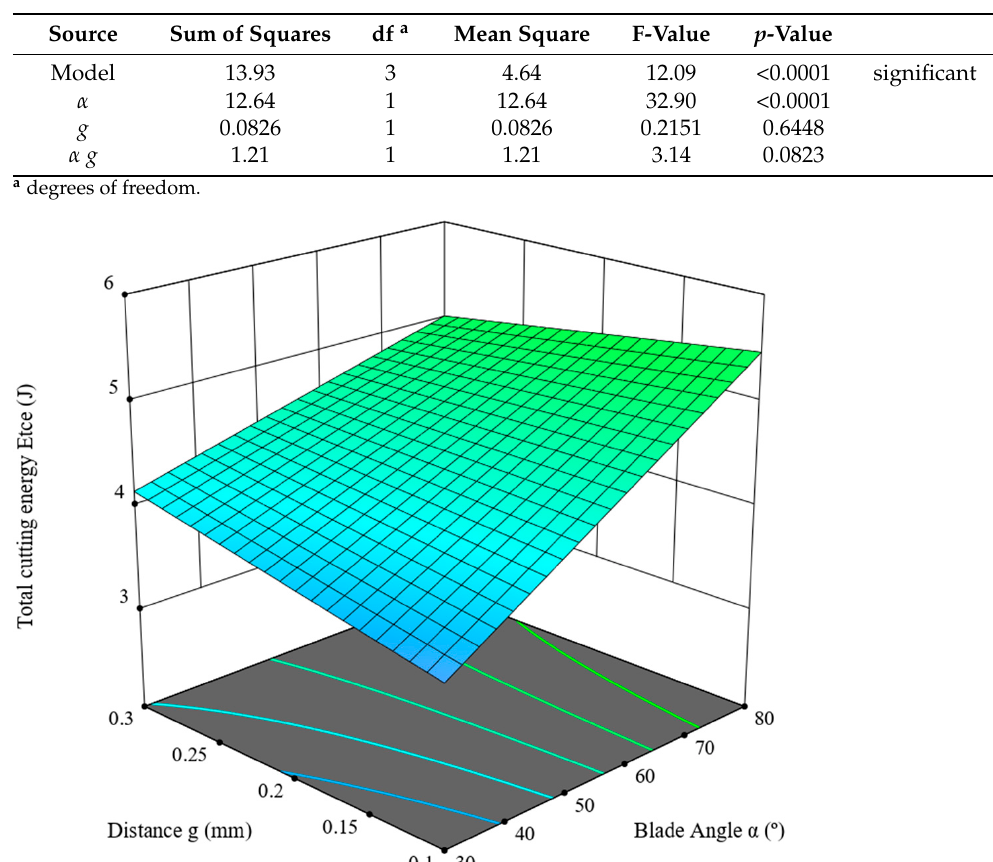
Figure 9. Total cutting energy, E tce , in the function of the blade angle, α , of the distance, g.